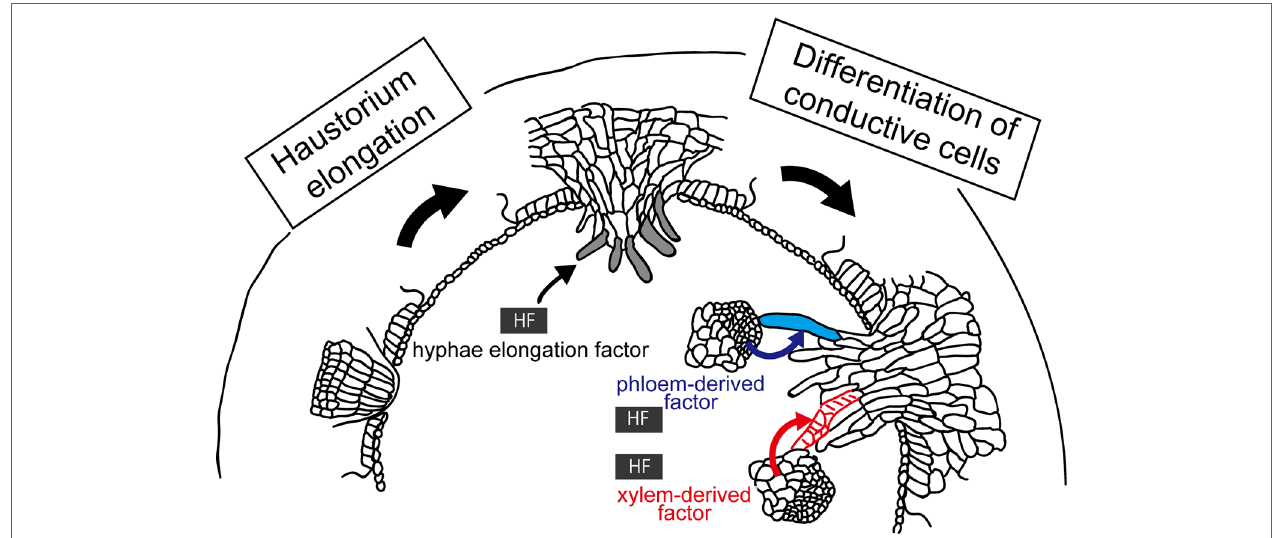
FIGURe 5 | Involvement of host factors (HFs) in the elongation and differentiation of searching hyphae. (Left) HF inducing elongation of searching hyphae (left) has been hypothesized because digitate cells or file cells of C. campestris initiated in a host-independent manner do not show further development of searching hyphae without host. (Right) HF has been implied in the differentiation of searching hypha cells into xylem (red lines) and phloem conductive elements (blue), because upon contacting xylem vessels or phloem sieve tubes of the host, the hyphal cells starts to differentiate into respective conductive elements. These HFs have not been identified